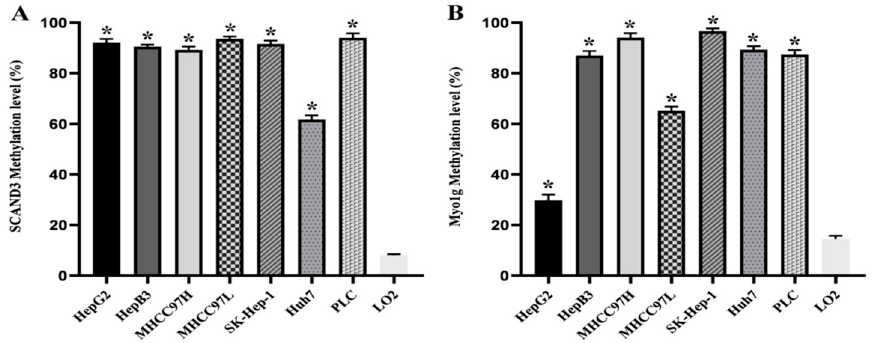
Figure 1. The methylation levels of SCAND3 and Myo1g in seven hepatocellular carcinoma (HCC) cell lines and the normal hepatocyte cell line LO2. ( A ) SCAND3 average methylation levels in seven HCC cell lines (HepG2, HepB3, MHCC97H, MHCC97L, SK-Hep-1, Huh7, PLC) and LO2 were 92.07%, 90.53%, 89.23%, 93.64%, 91.60%, 61.73%, 94.07%, 8.07%, respectively. ( B ) Myo1g average methylation levels in seven HCC cell lines (HepG2, HepB3, MHCC97H, MHCC97L, SK-Hep-1, Huh7, PLC) and LO2 were 29.73%, 87.00%, 94.10%, 65.17%, 96.96%, 89.30%, 87.37%, 14.47%, respectively. SCAND3 and Myo1g hypermethylation were more prominent in seven HCC cell lines than in LO2. Statistical comparisons were computed using the unpaired t -test, * p < 0.05.